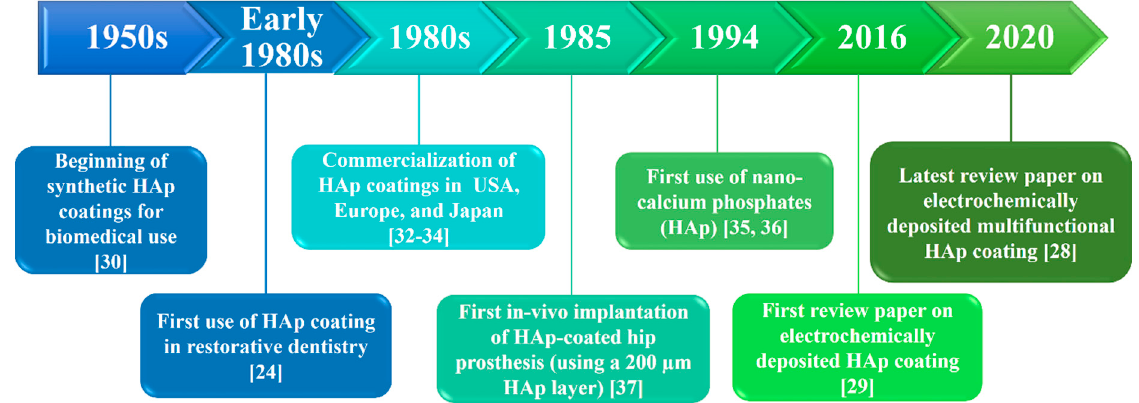
Figure 1. A timeline for the development of electrochemically deposited hydroxyap-atite (HAp) coatings.